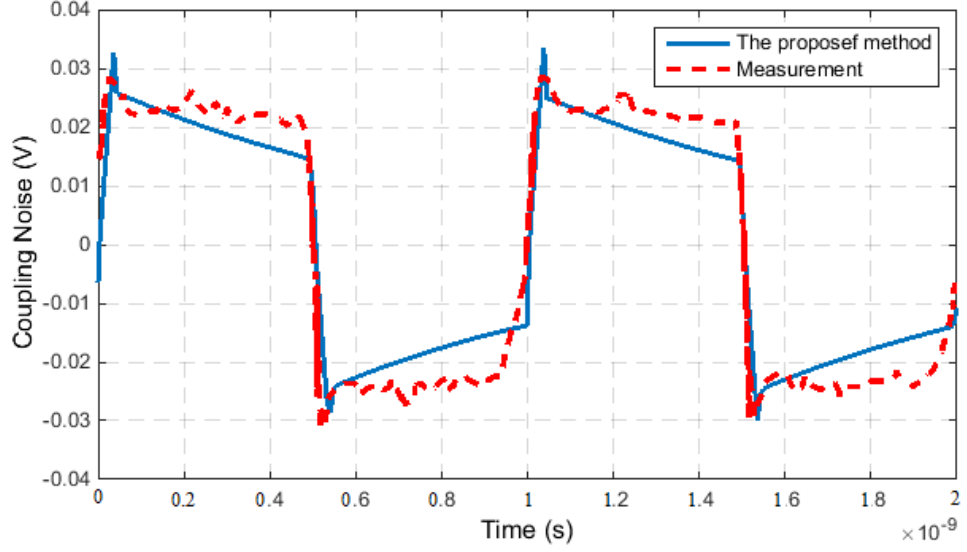
Figure 11. The proposed method and measured coupling noise of the TSV–active circuit (the input clock frequency at port 1 is 1 GHz).